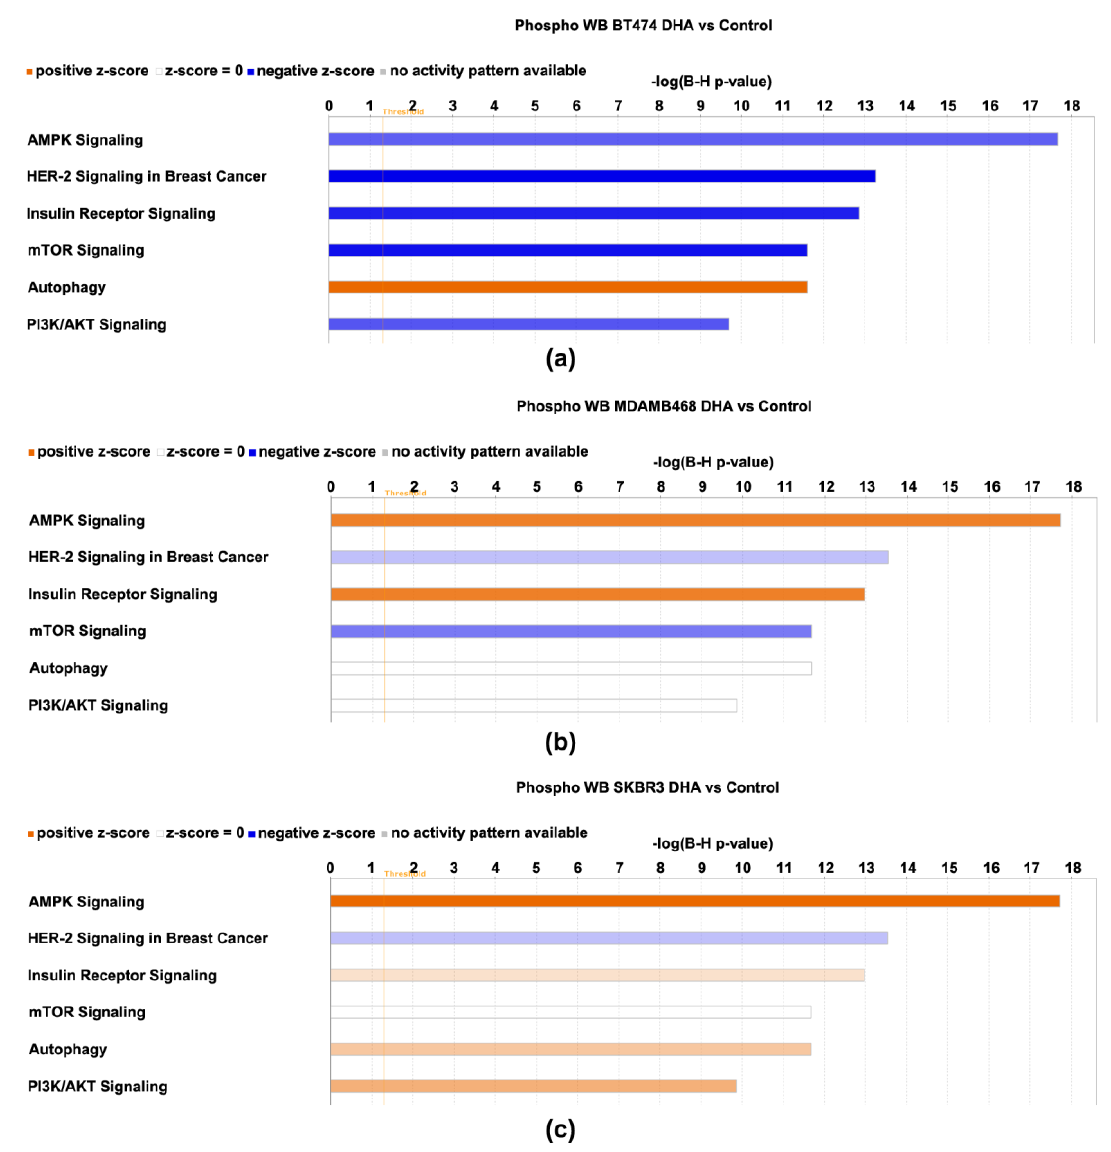
Figure 6. Canonical pathways affected by 4-oxo-DHA as predicted by the phosphoproteome data sets listed in Tables 1 – 4. Canonical pathways shown for cell line ( a ) BT474, ( b ) MDAMB468, and ( c ) SKBR3. The − log(B-H p -values) is the multi = comparison-adjusted probability that the association between the protein expression set and the canonical pathway is due to chance. The direction of the differences in expression between the treatment and the control for each protein component was compared to that tabulated in the IPA knowledge basis (>80,000 database entries) that support the canonical pathways that have been annotated and a z-score was computed. A z-score ≤ −2 indicates the pathway is inhibited and ≥ 2 that the pathway is activated. If the z-score is between − 2 and 2, no prediction of inhibition or activation is deduced. Shades of red indicate that the pathway was activated by treatment with 4-oxo-DHA; greater color intensity indicates stronger evidence of activation. Shades of blue indicate that the pathway was inhibited by treatment with 4-oxo-DHA; greater color intensity indicates stronger evidence of inhibition. The absence of coloration indicates that the evidence was not strong enough to permit a prediction of pathway status.